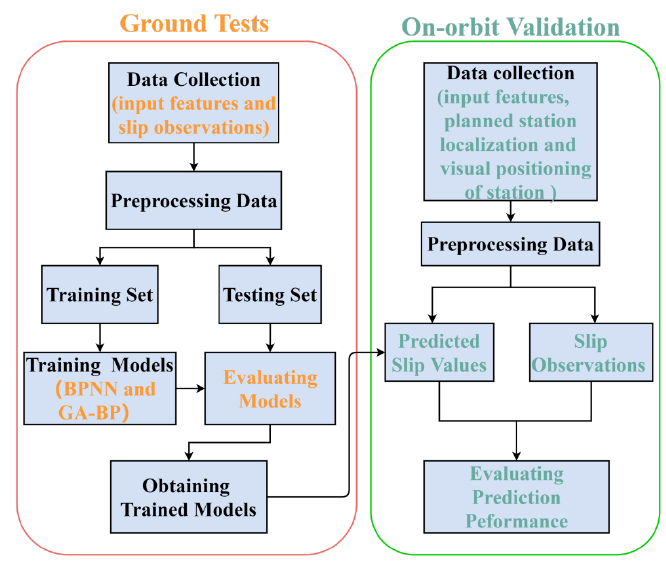
Figure 5. The research work of this